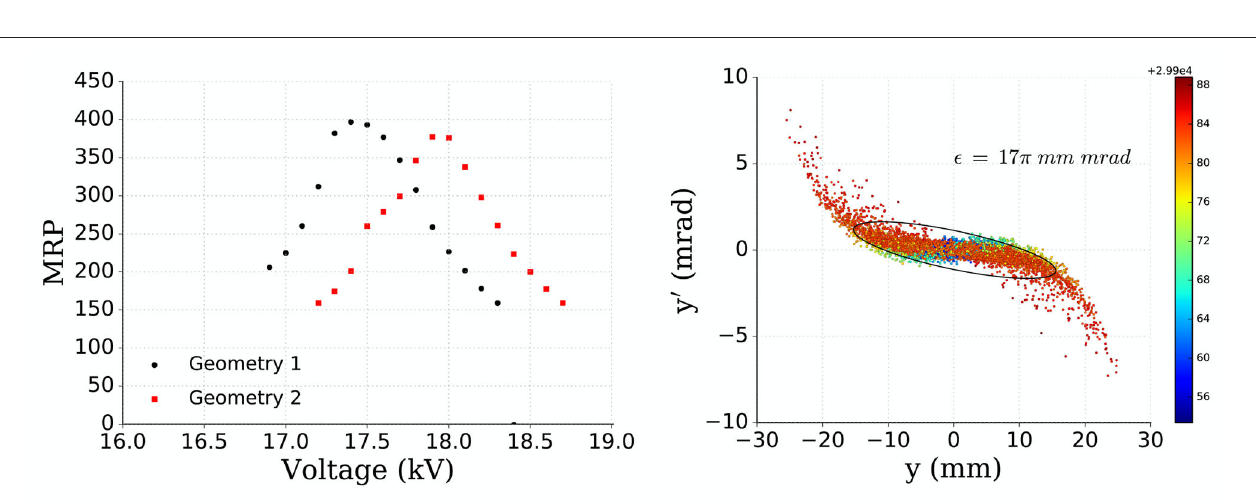
FIGURE 4 | Geometry of the MEDICIS beamline simulated with SIMION showing the electromagnetic elements included in the simulations. The black lines show the charged particle trajectories.